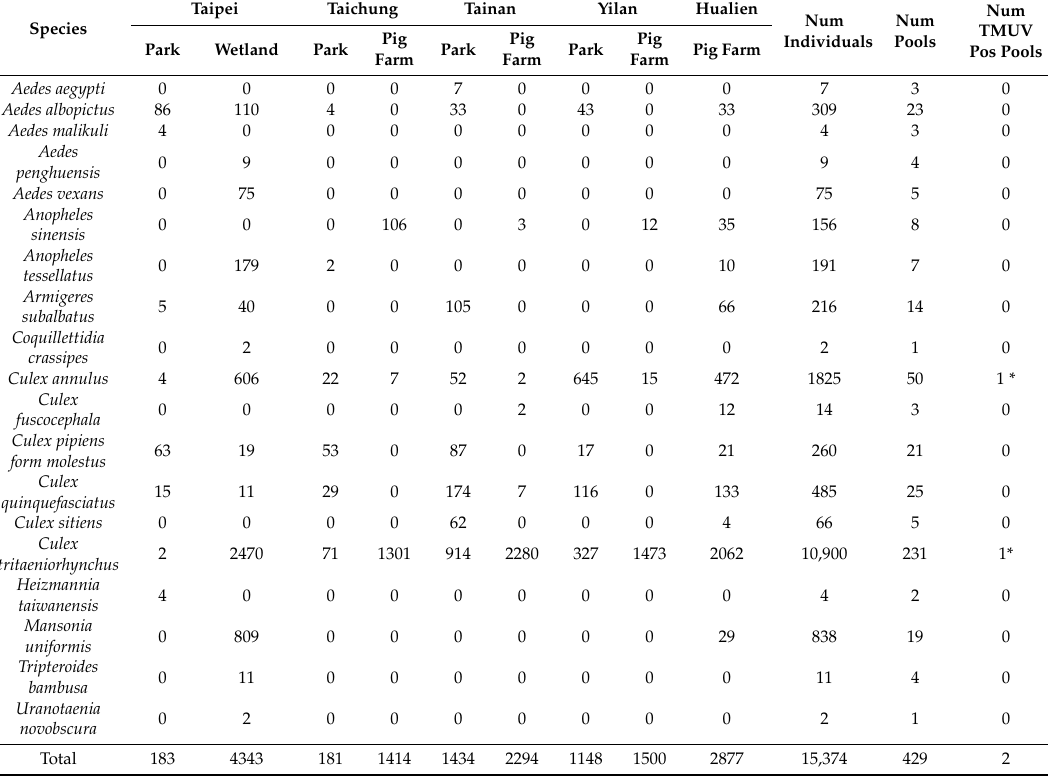
Table 3. Summary of the mosquito species, number of mosquitoes, and pools tested and positive Tembusu virus